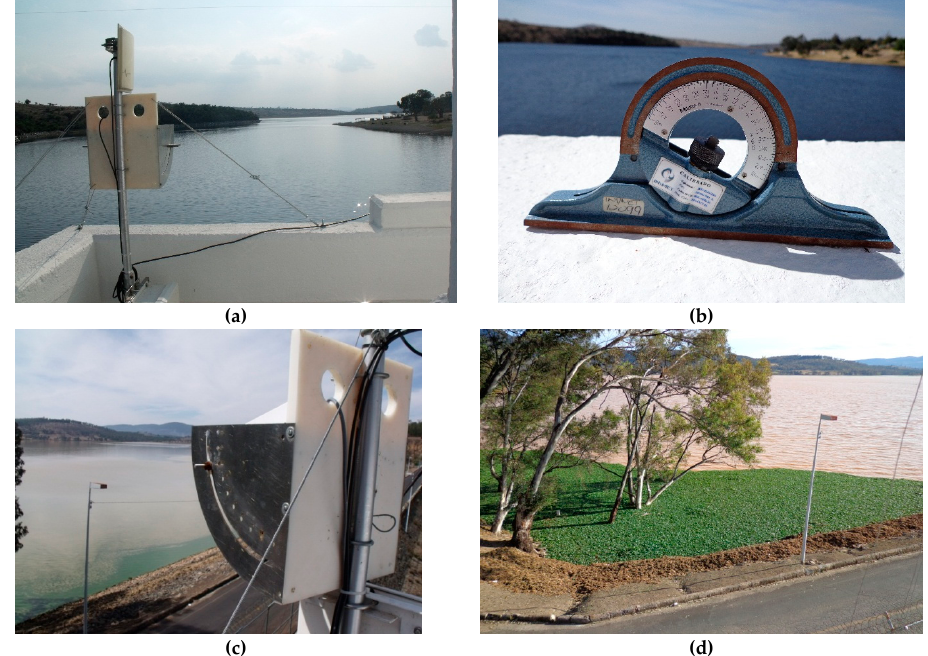
Figure 3. Field experiment: ( a ) monitoring system with an inclined Lidar at Valsequillo (looking west); ( b ) bubble inclinometer used to check the Lidar incidence-angle; ( c ) monitoring system with another inclined Lidar at Cointzio (looking south-east); ( d ) accumulation of water hyacinth near the bank of the Cointzio reservoir (13 December 2013), where the Lidar was pointing.